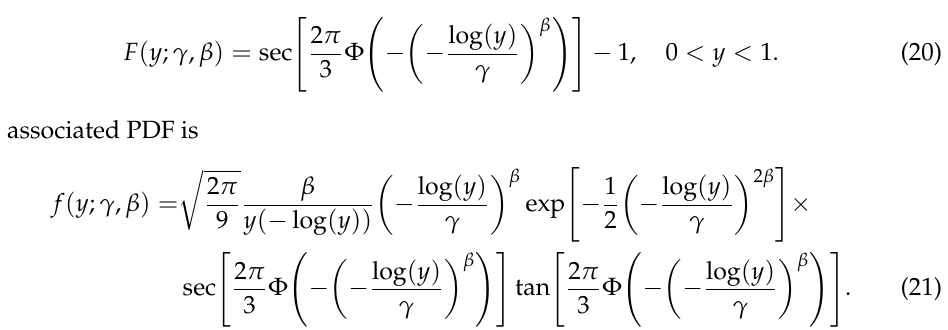
The associated PDF is